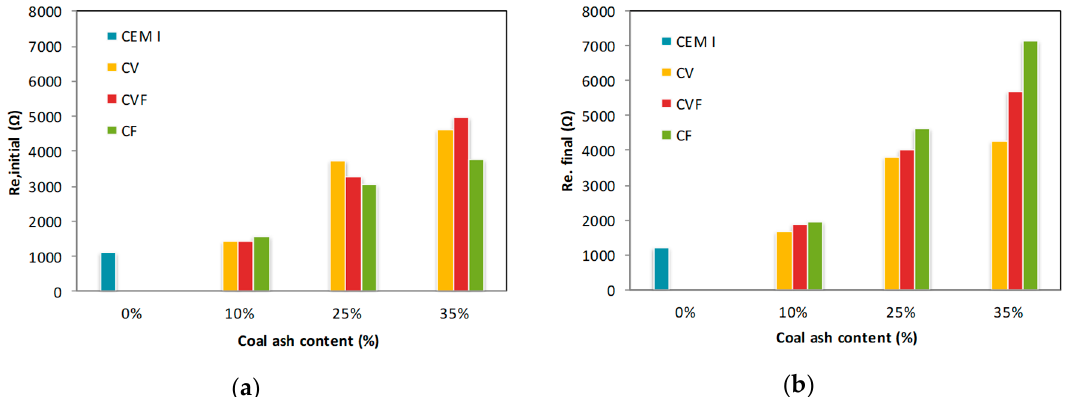
Figure 4. Electrical resistances measured in the bars embedded in blended mortars: ( a ) Initial, R e,initial and ( b ) final, R e,final .